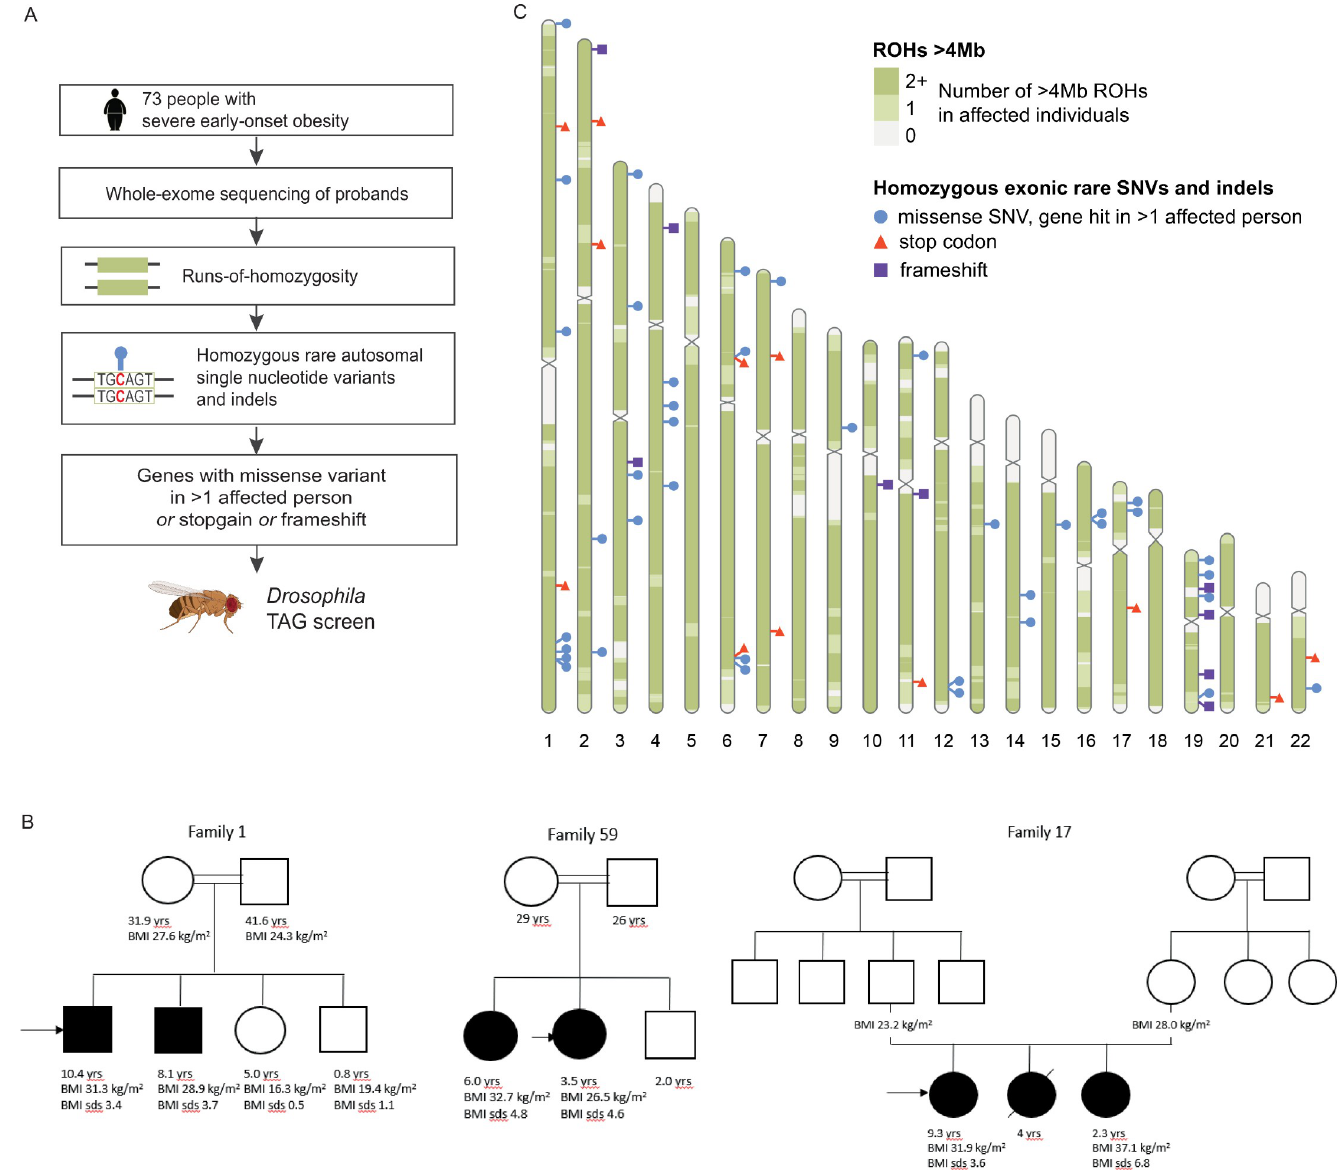
Fig 1. Identification of genes harbouring homozygous rare variants in severely obese individuals. (A) Schematic of the approach used to identify candidate human obesity genes and the prioritisation of genes containing rare exonic SNVs and indels for screening in Drosophila . (B) All probands had severe obesity and presented in early childhood, as exemplified in 3 family pedigrees shown. Males (squares) and females (circles) with obesity (filled symbols) are indicated. BMI in children under 18 years is adjusted for age and sex and shown as BMI SDS. Arrows indicate probands who were sequenced; slashed lines indicate deceased individuals; double lines indicate consanguineous union. Family numbers refer to S1 Table . (C) Cumulative medium to large ROHs in affected cases and prioritised homozygous exonic rare SNVs and indels. The autosomal karyotype heatmap illustrates the cumulative coverage of medium to large ROHs ( > 4 Mb) among the affected individuals, based on estimates of ROHs using WES data (displayed in bins of size 10 5 bp). Markers show the location and consequence of homozygous rare exonic SNVs and indels within any ROHs ( > 100 kb). Stop codons and frameshifts are displayed, and missense variants where > 1 affected person had a missense variant in the same gene. Variant markers are shown per gene (S2 Table) . BMI, body mass index; indel, insertion/deletion; ROH, run of homozygosity; SDS, standard deviation score; SNV, single- nucleotide variant; WES, whole-exome